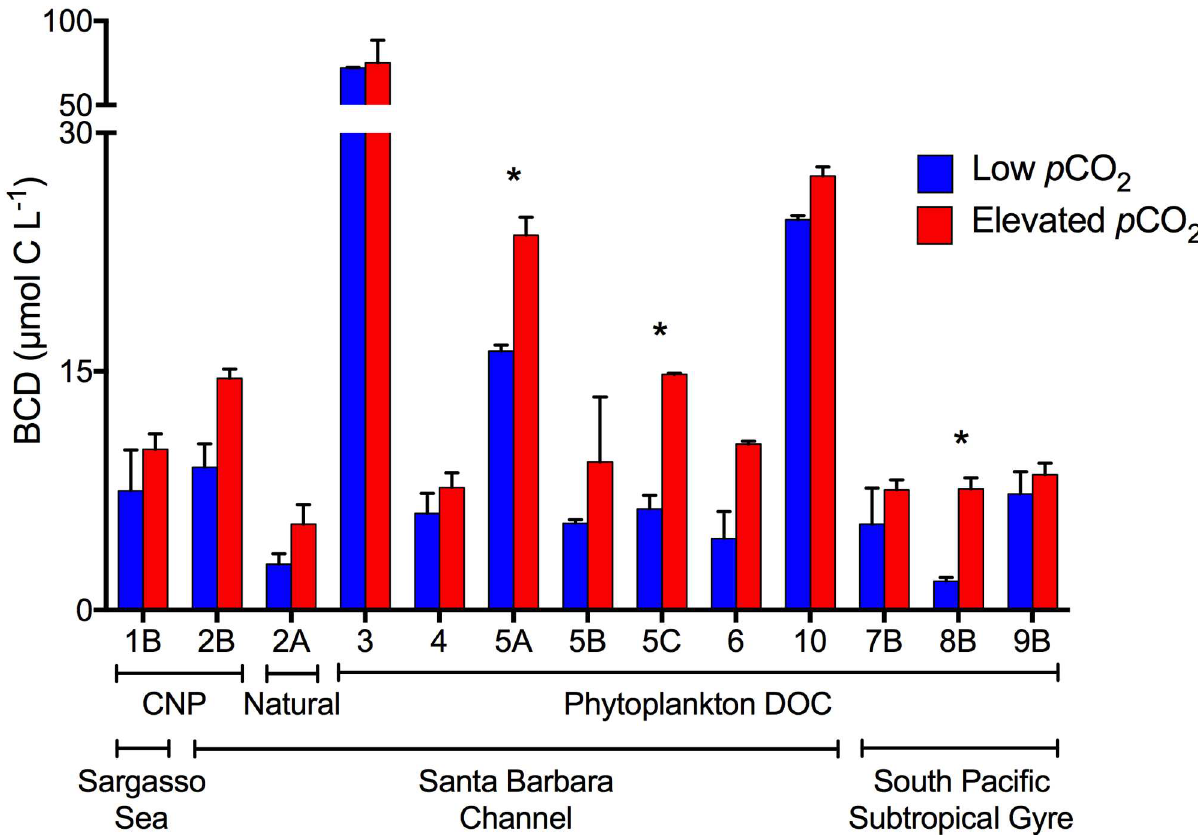
Fig 5. Bacterioplankton Carbon Demand. Mean ( ± SD) bacterioplankton carbon demand(BCD) averaged across duplicateincubations and calculatedas the changein DOC from T 0 to stationary phase. Changein DOC was calculatedas TOC less the carbon content of bacterioplankton biomass (using a carbonconversionfactor of 30 fg C cell -1 for bacterioplankton in the Santa Barbara Channeland 10 fg C cell -1 for bacterioplankton in the SargassoSea and South Pacific SubtropicalGyre). Colors denote BCD at elevated p CO 2 (red) and low (ambient or pre-industrial) p CO 2 (blue). Numbers refer to the experiment number (Table 1). Only experiments where a changein TOC was resolvableare shown.